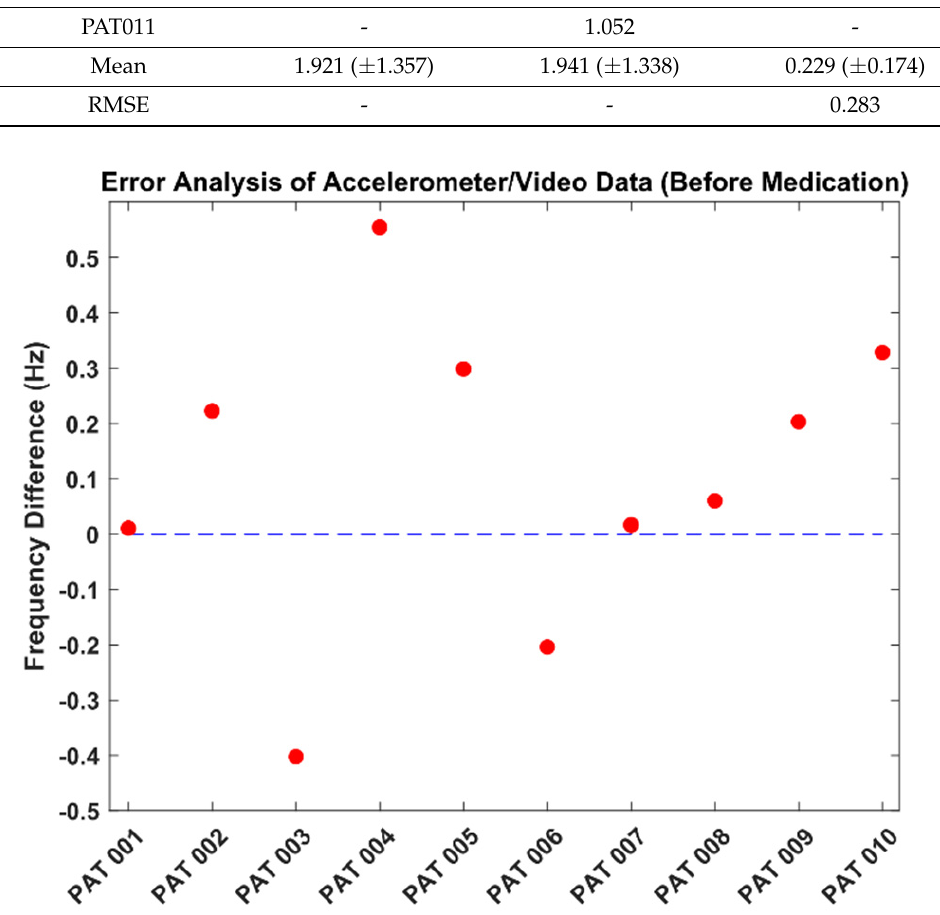
Figure 6. Frequency error analysis (analysis was performed in terms of dominant frequency for all patients).